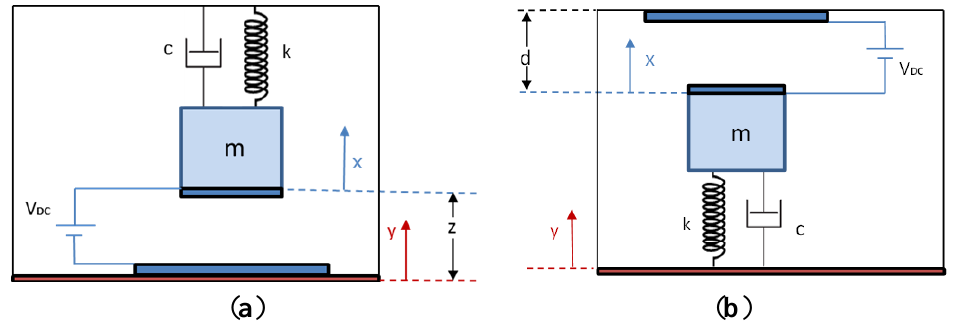
Figure 12. A model of a parallel plate capacitor switch for lower and upper electrode positions, ( a ) lower (switch 1); ( b ) upper (switch